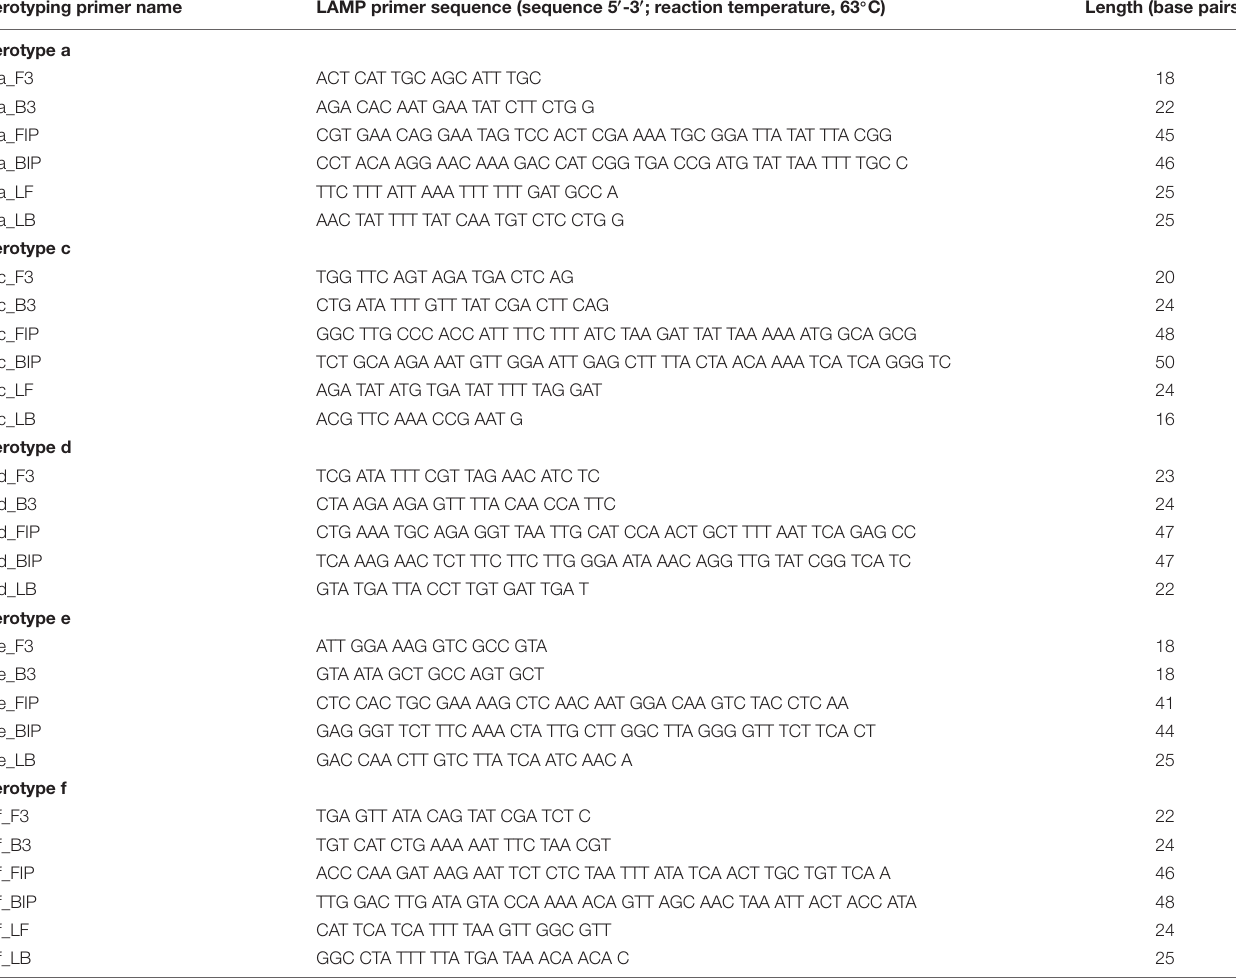
TABLE 2 | (A) LAMP Primer sequences in this study.